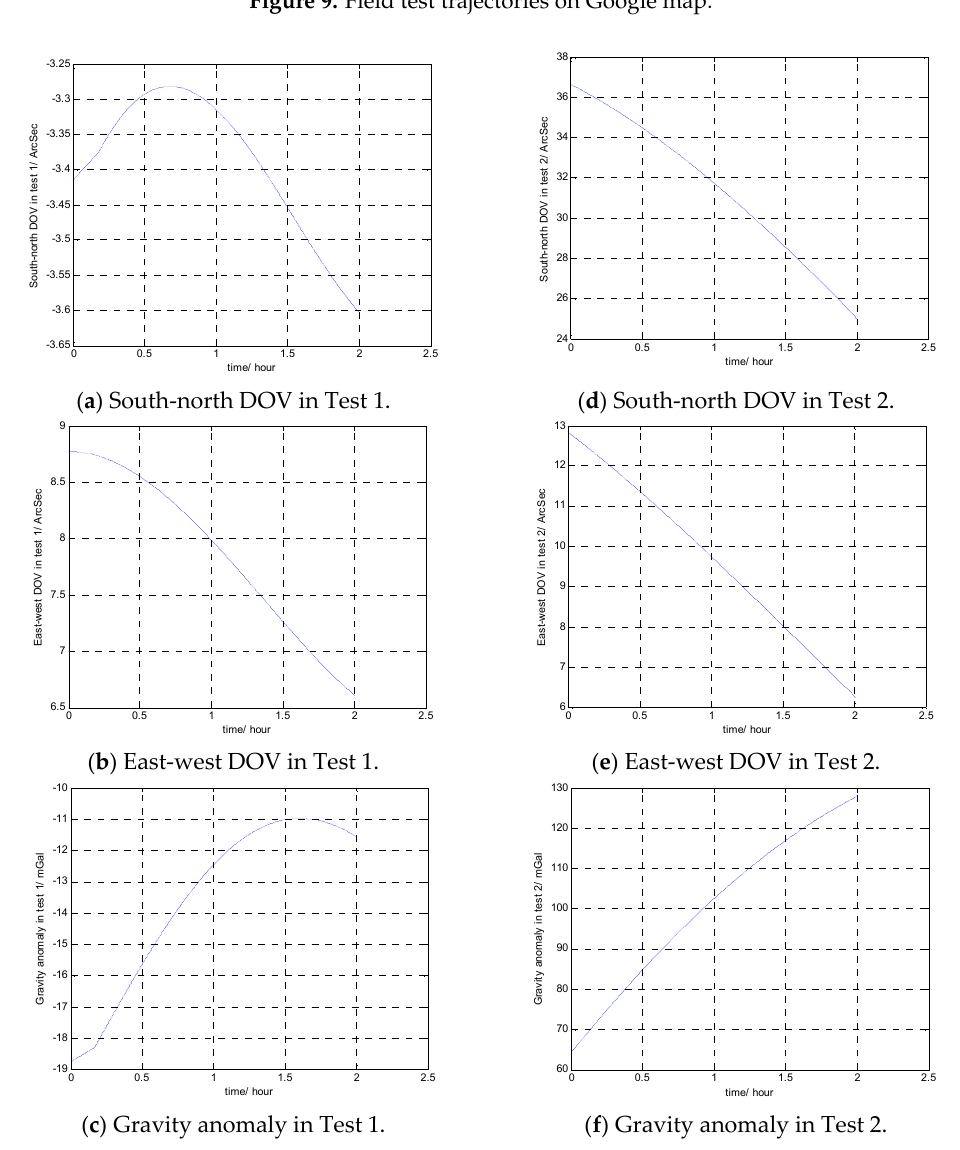
Figure 10. The gravity anomaly and deflections of the vertical (DOVs) of the two tests.